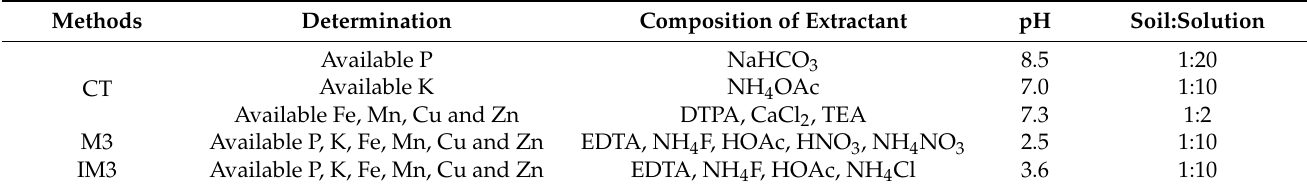
Table 2. Comparison of three test methods for determination of soil available